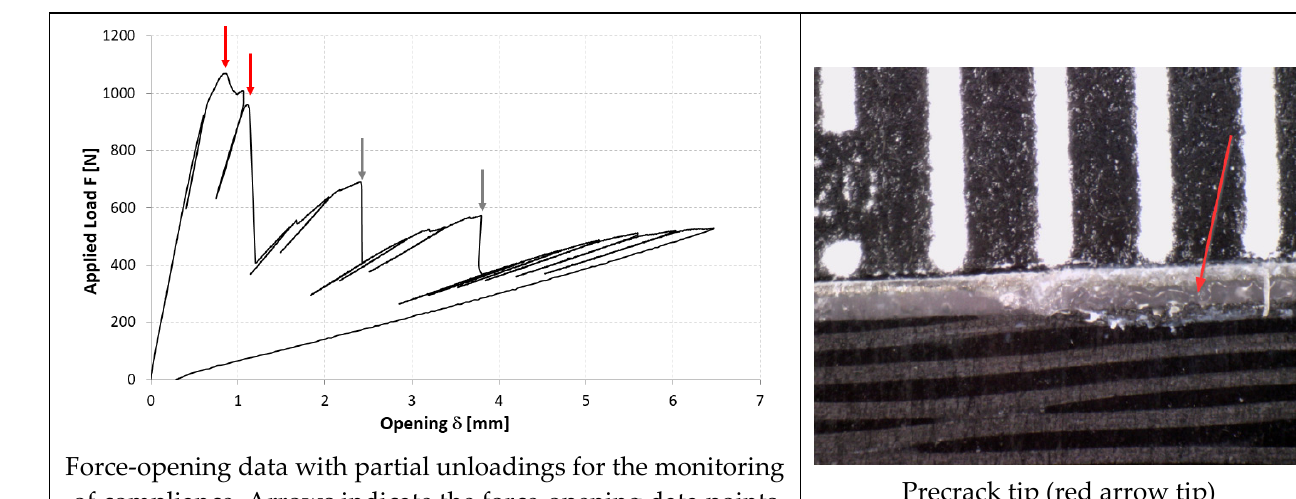
of compliance. Arrows indicate the force-opening data points for the calculation of G.